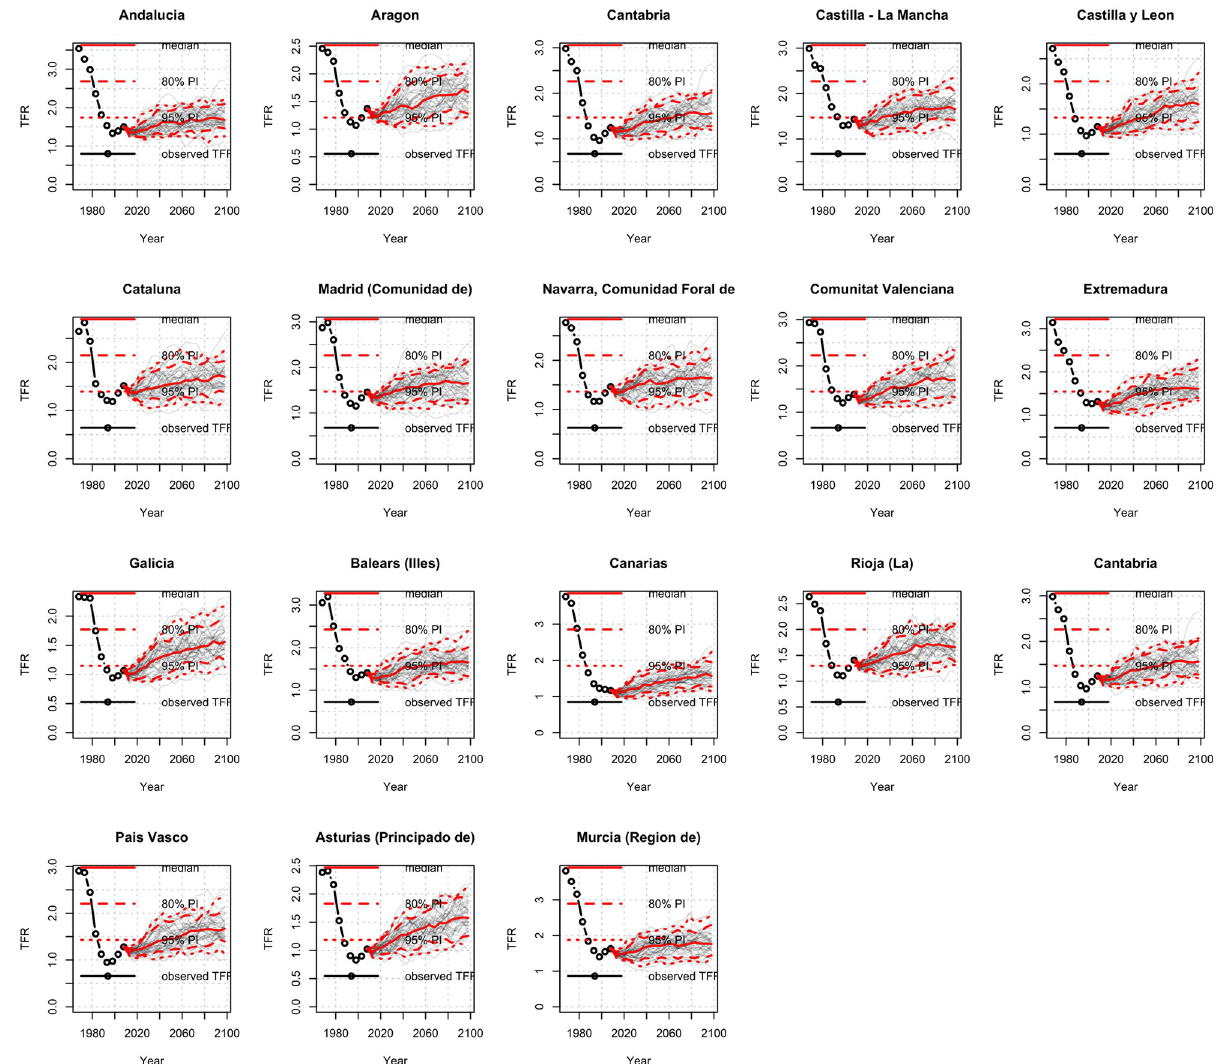
Fig 7. Probabilistic projections of the TFR at the regional level. TFR projections: median, 80%, and 95% prediction intervals and high/low fertility variant for each region. Source: own elaboration.